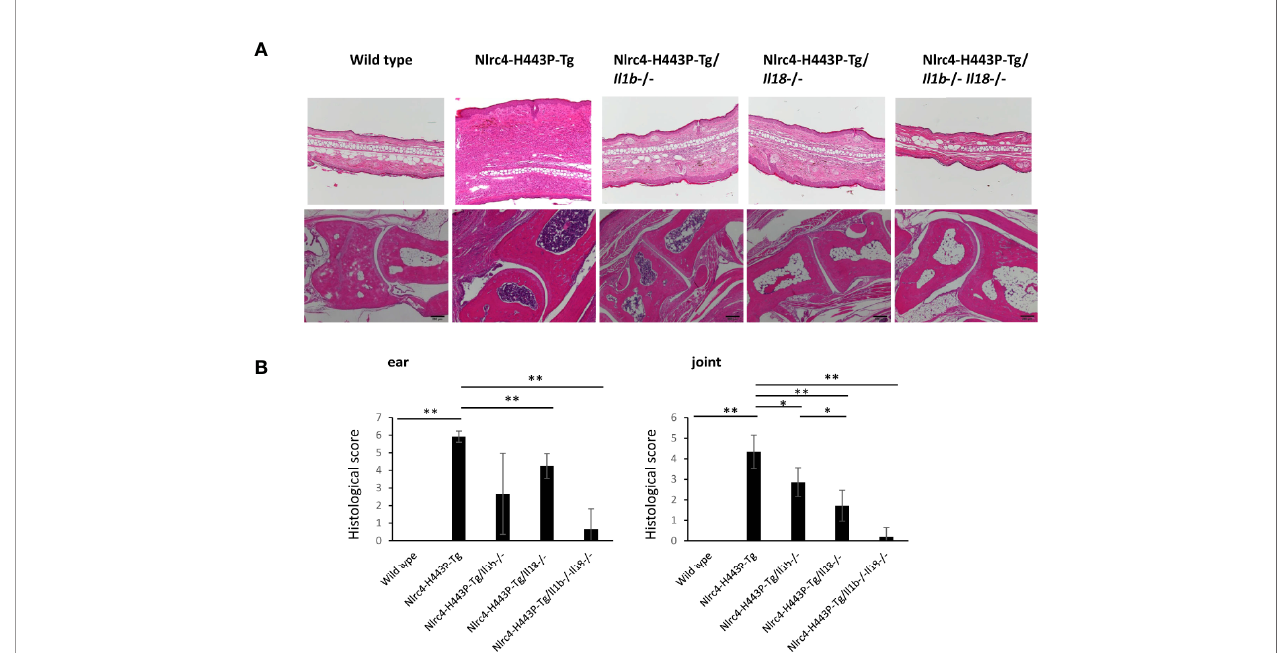
FIGURE 2 | IL-1 b – and Il-18 – mediated in fl ammation in the skin and joints of Nlrc4-H443P-Tg mice. (A) Histological sections of ear skin and ankle joints in control, Nlrc4-H443P-Tg, Nlrc4-H443P-Tg/Il1b − / − , Nlrc4-H443P-Tg/Il18 − / − , and Nlrc4-H443P-Tg/Il1b − / − Il18 − / − mice at the age of 20 weeks were stained with hematoxylin and eosin. (B) The histological scores were evaluated in the ear skin and ankle joints in in control, Nlrc4-H443P-Tg, Nlrc4-H443P-Tg/Il1b − / − , Nlrc4-H443P-Tg/Il18 − / − , and Nlrc4-H443P-Tg/Il1b − / − Il18 − / − mice at the age of 20 weeks (N = 8 in each group). Data are shown as the mean ± SD. *P < 0.05, **P <